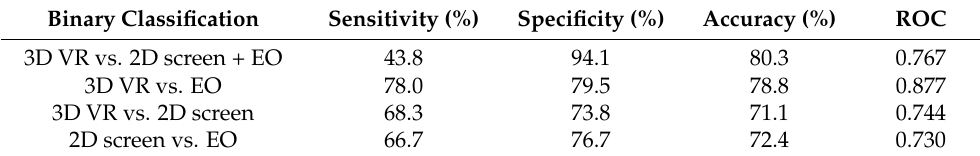
Figure 3. The fractal dimension from EEG activity during three conditions, no-eyes-open task (red), 2D screen task (blue) and 3D VR task (orange). Table 8. Performance of binary classifications using ANN